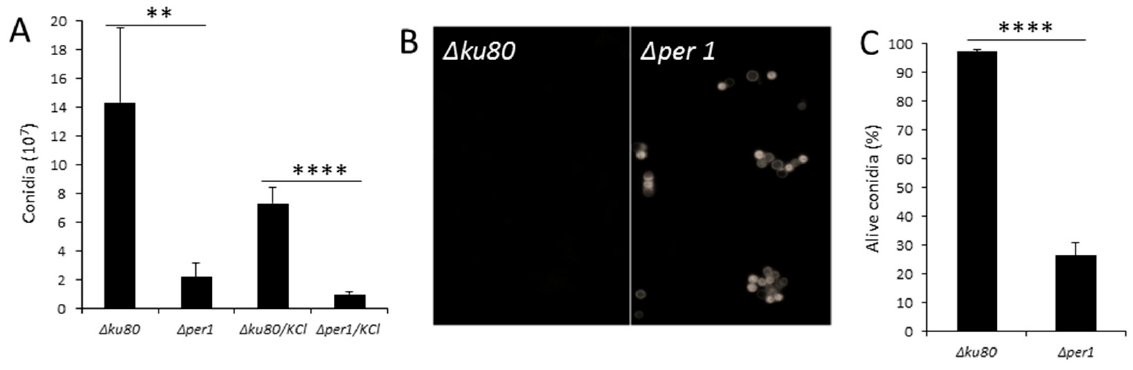
Figure 4. Conidia phenotypes of the Δ per1 strain. ( A ) Conidiation after 1 week on Malt medium; ( B ) FITC staining of 2 weeks-old conidia (10 6 conidia/mL, acquisition: 1 ms); ( C ) Viability of 40-day-old conidia. (Values are the mean and standard deviation of three different experiments, statistical difference are indicated by ** p <0.01; **** p <0.0001).